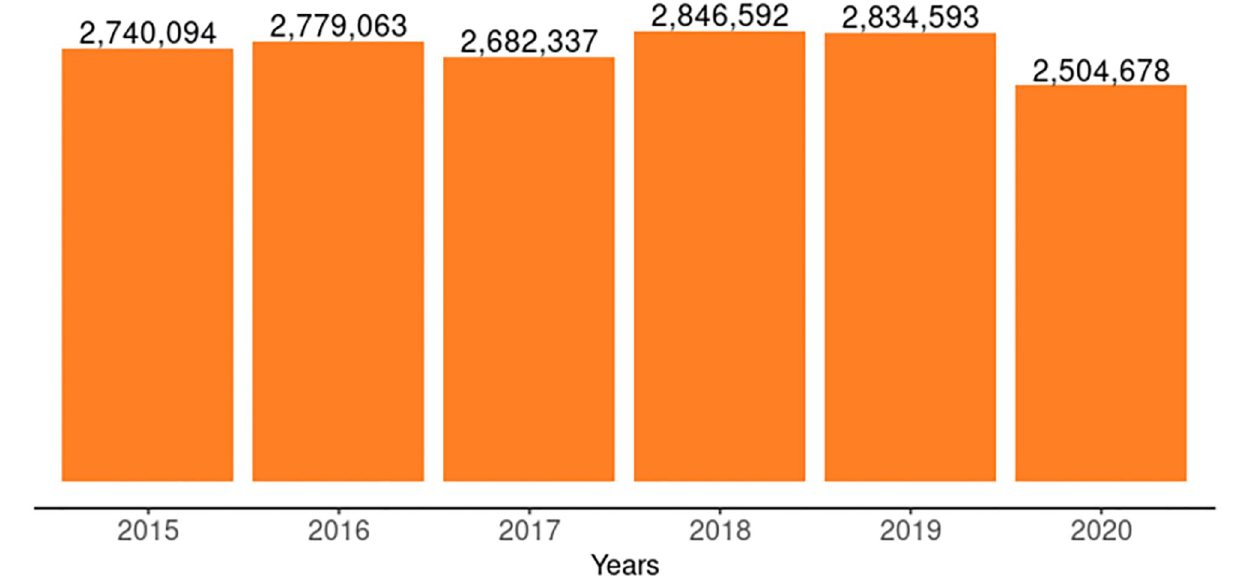
Fig 5. Number of pregnant women tested for HIV and received results annually from 2015–2020.